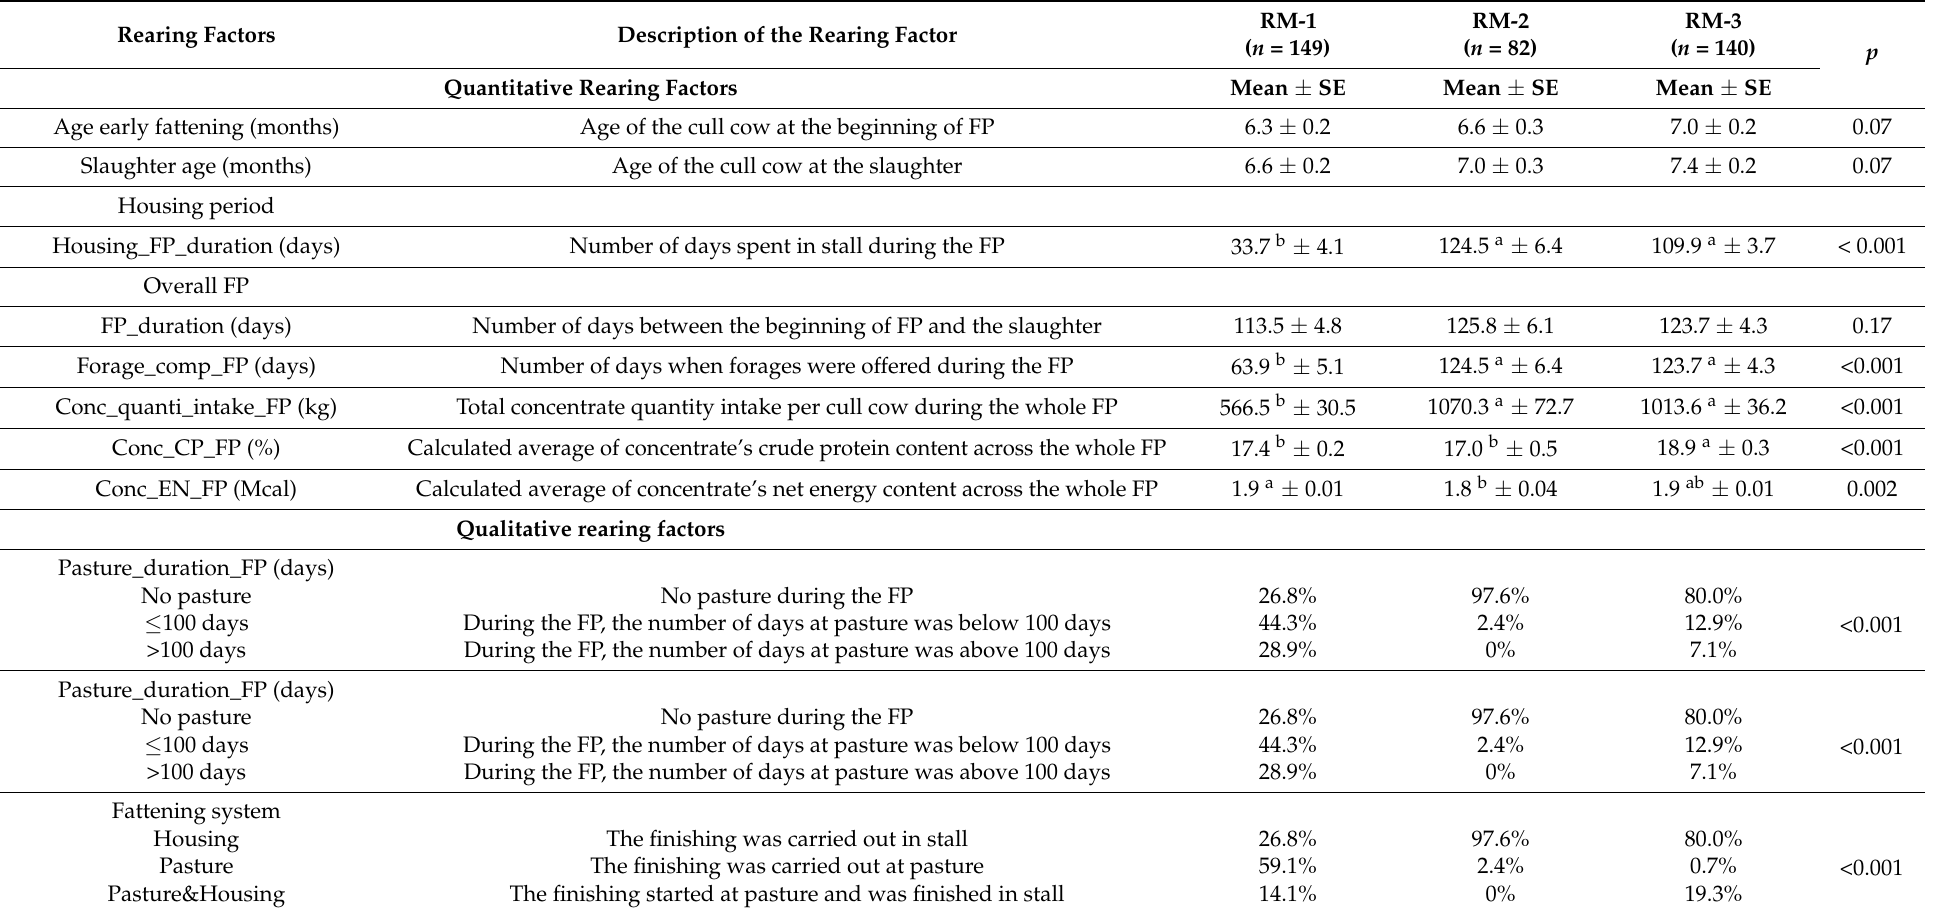
Table 6. Rearing factors characterizing the fattening period (FP) of the rearing managements (RM) applied during the cull cows’ whole